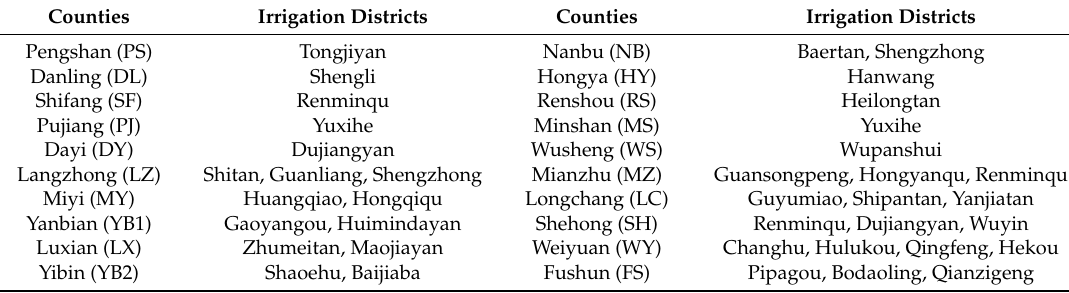
Table 1. Counties and irrigation districts selected for sampling in